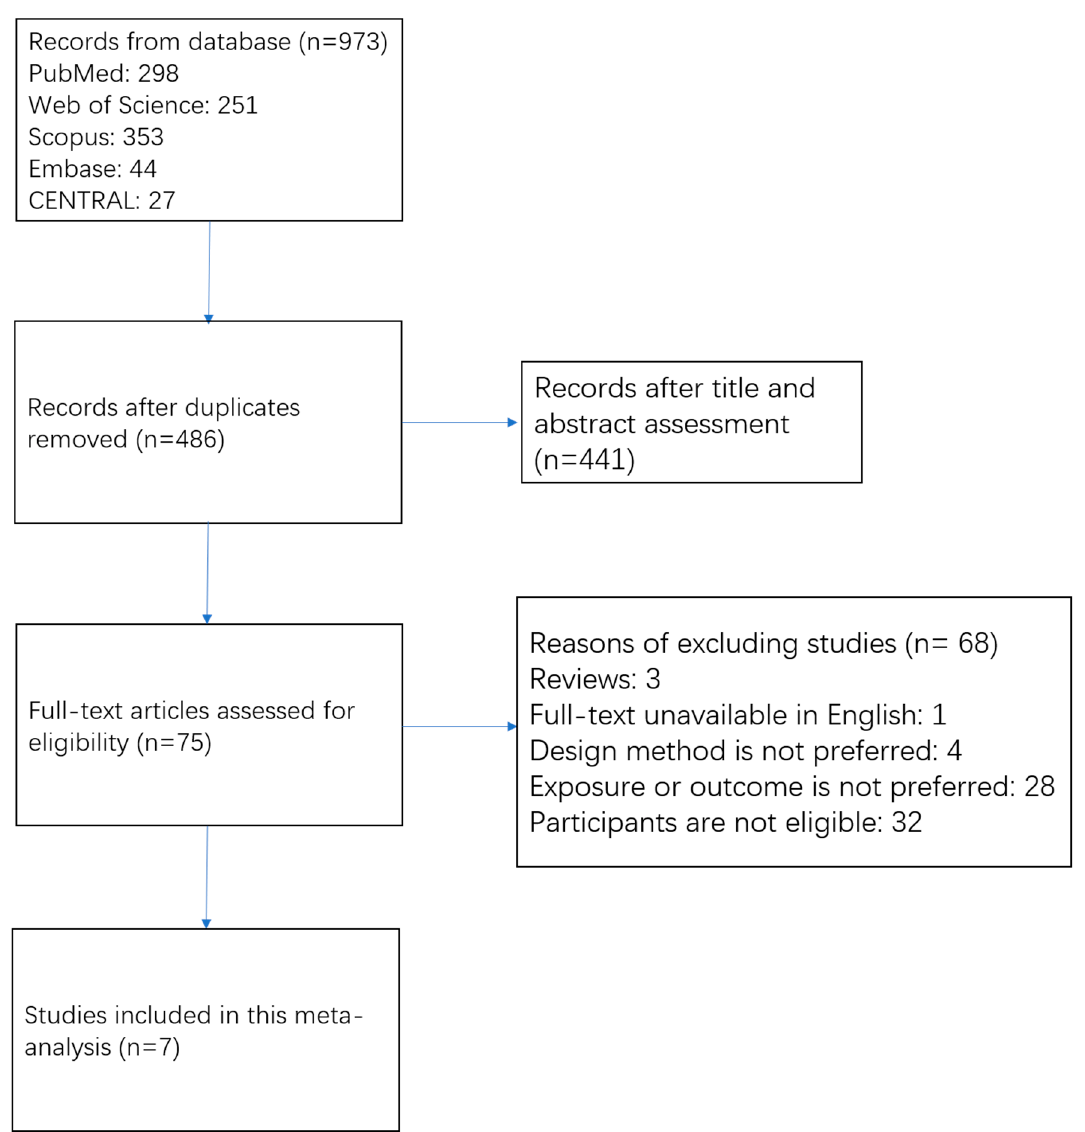
Figure 1. Flow chart of study selection.